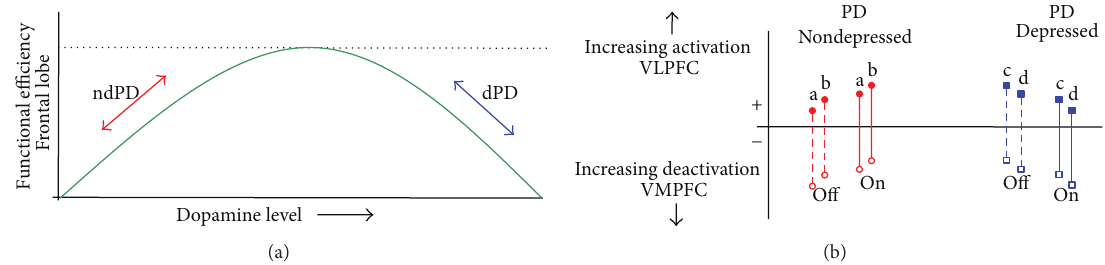
Figure 5: (a) Illustrating a hypothetical inverted-U dependence of frontal lobe function on dopaminergic medication associated with individual variation in baseline dopamine level. (b) Nondepressed PD patients (red) are positioned at the upstroke lower end of the curve: they reduce their level of VMPFC deactivation and increase VLPFC activation with levodopa medication. Depressed PD patients (blue) are positioned at the downstroke upper end of the curve: they increase their level of VMPFC deactivation and decrease VLPFC activation with levodopa medication. Labels a, b, c, and d indicate representative ndPD and dPD patients; open symbols denote the VMPFC and closed symbols the VLPFC brain regions; dashed lines represent the activity gap off dopaminergic medication, while solid lines represent that on